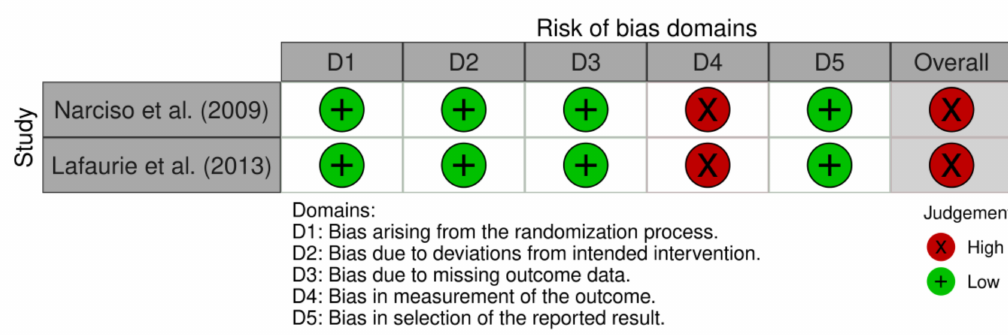
Figure 2. RoB 2 traffic light plot bias